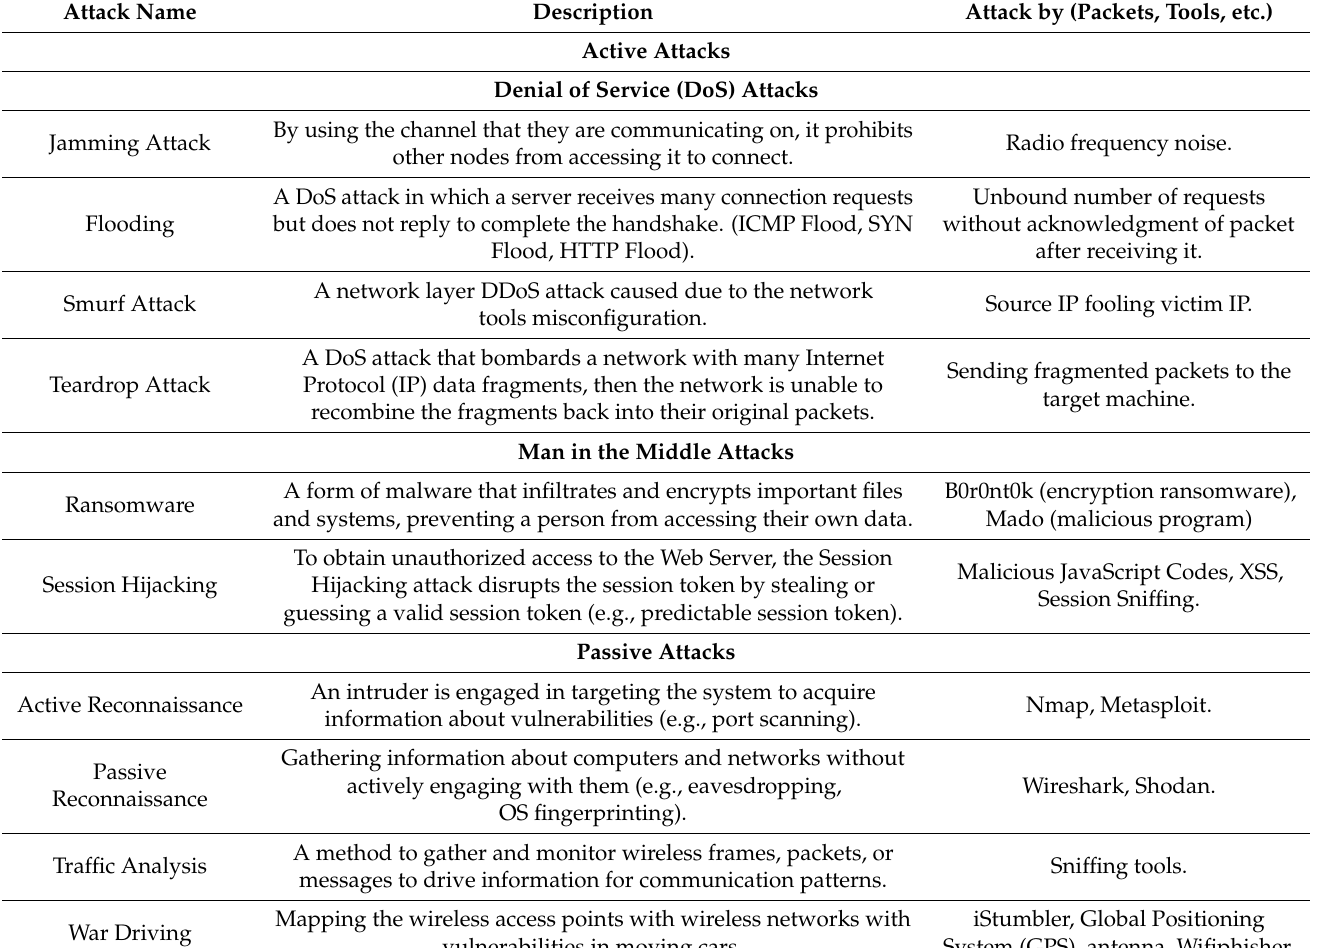
Table 1. Types of network